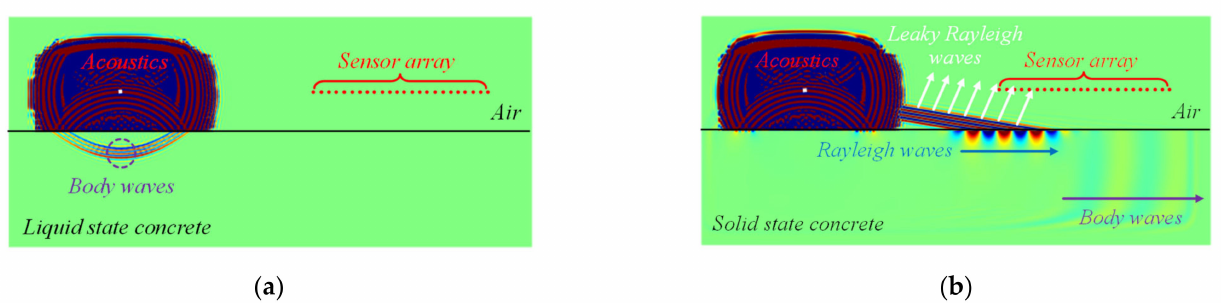
Figure 1. Wavefield snapshots generated from numerical simulations: ultrasonic wavefields at t = 300 µ s for the cases of ( a ) beginning of hydration ( E = 0.1 GPa) and ( b ) fully hydrated concrete ( E = 25 GPa).